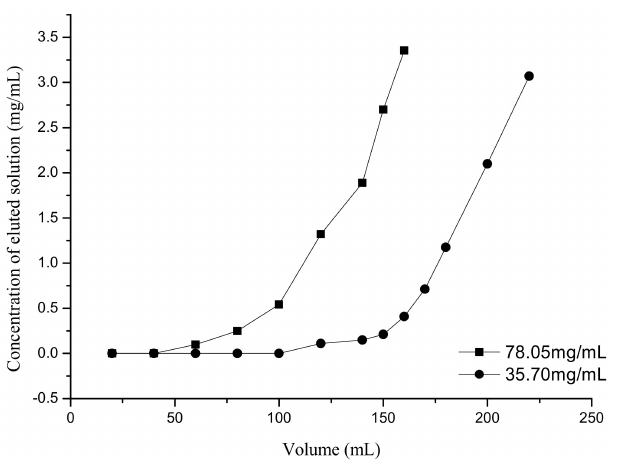
Figure 8. E ff ect of di ff erent sample concentration on adsorption of amygdalin with XDA-1